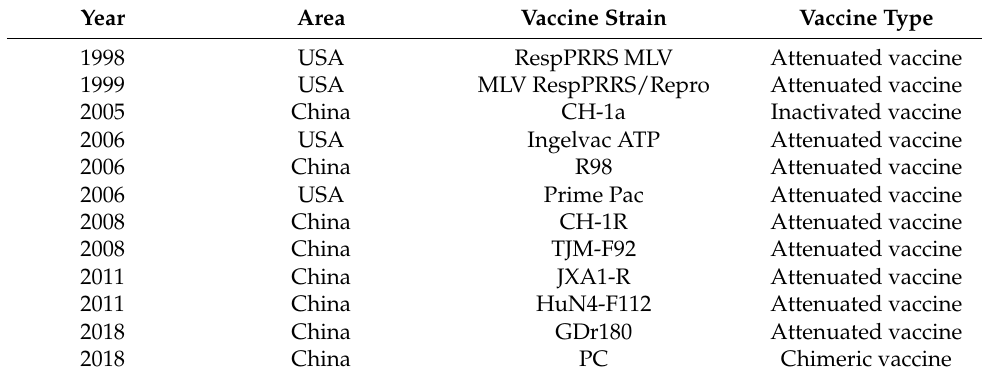
Table 1. PRRSV vaccines on the